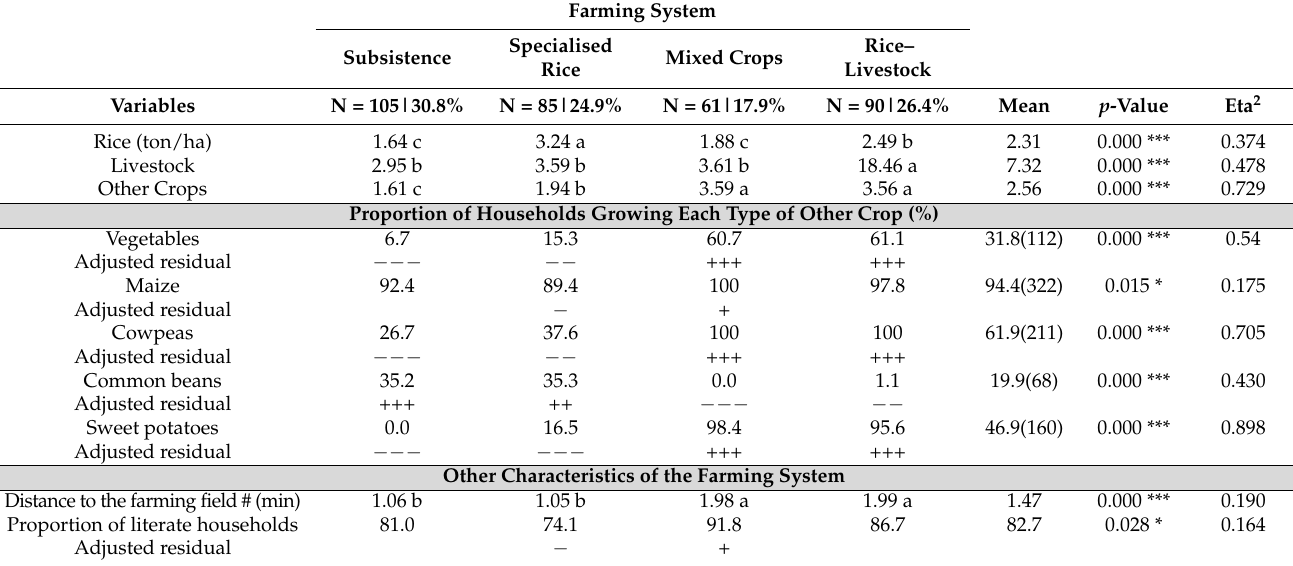
Table 4. Farming systems in the Ch ó kw è Irrigation Scheme, and some of their socio-economic determinants. Farming System Specialised Rice– Subsistence Mixed Crops Rice